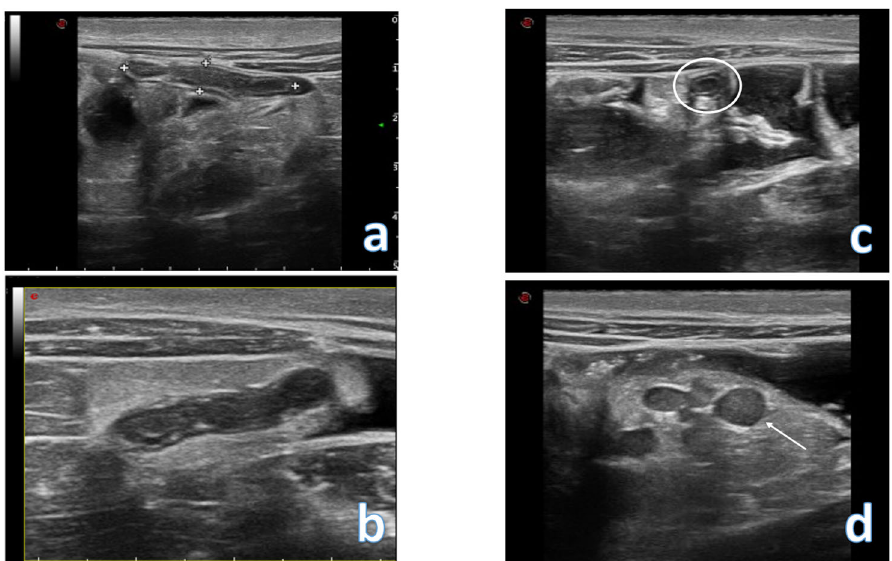
Figure 7. Images of a case of appendicitis. In figures ( a , b ) a longitudinal scan of the appendix is evident, which presents thickened walls and a hypoechoic appearance; compression with the probe does not allow the lumen to collapse and this maneuver evokes elective pain; In figure ( c ) the appendix is visualized in cross scan (white circle); In figure ( d ) multiple lymph nodes are evident in the right iliac fossa (white arrow).